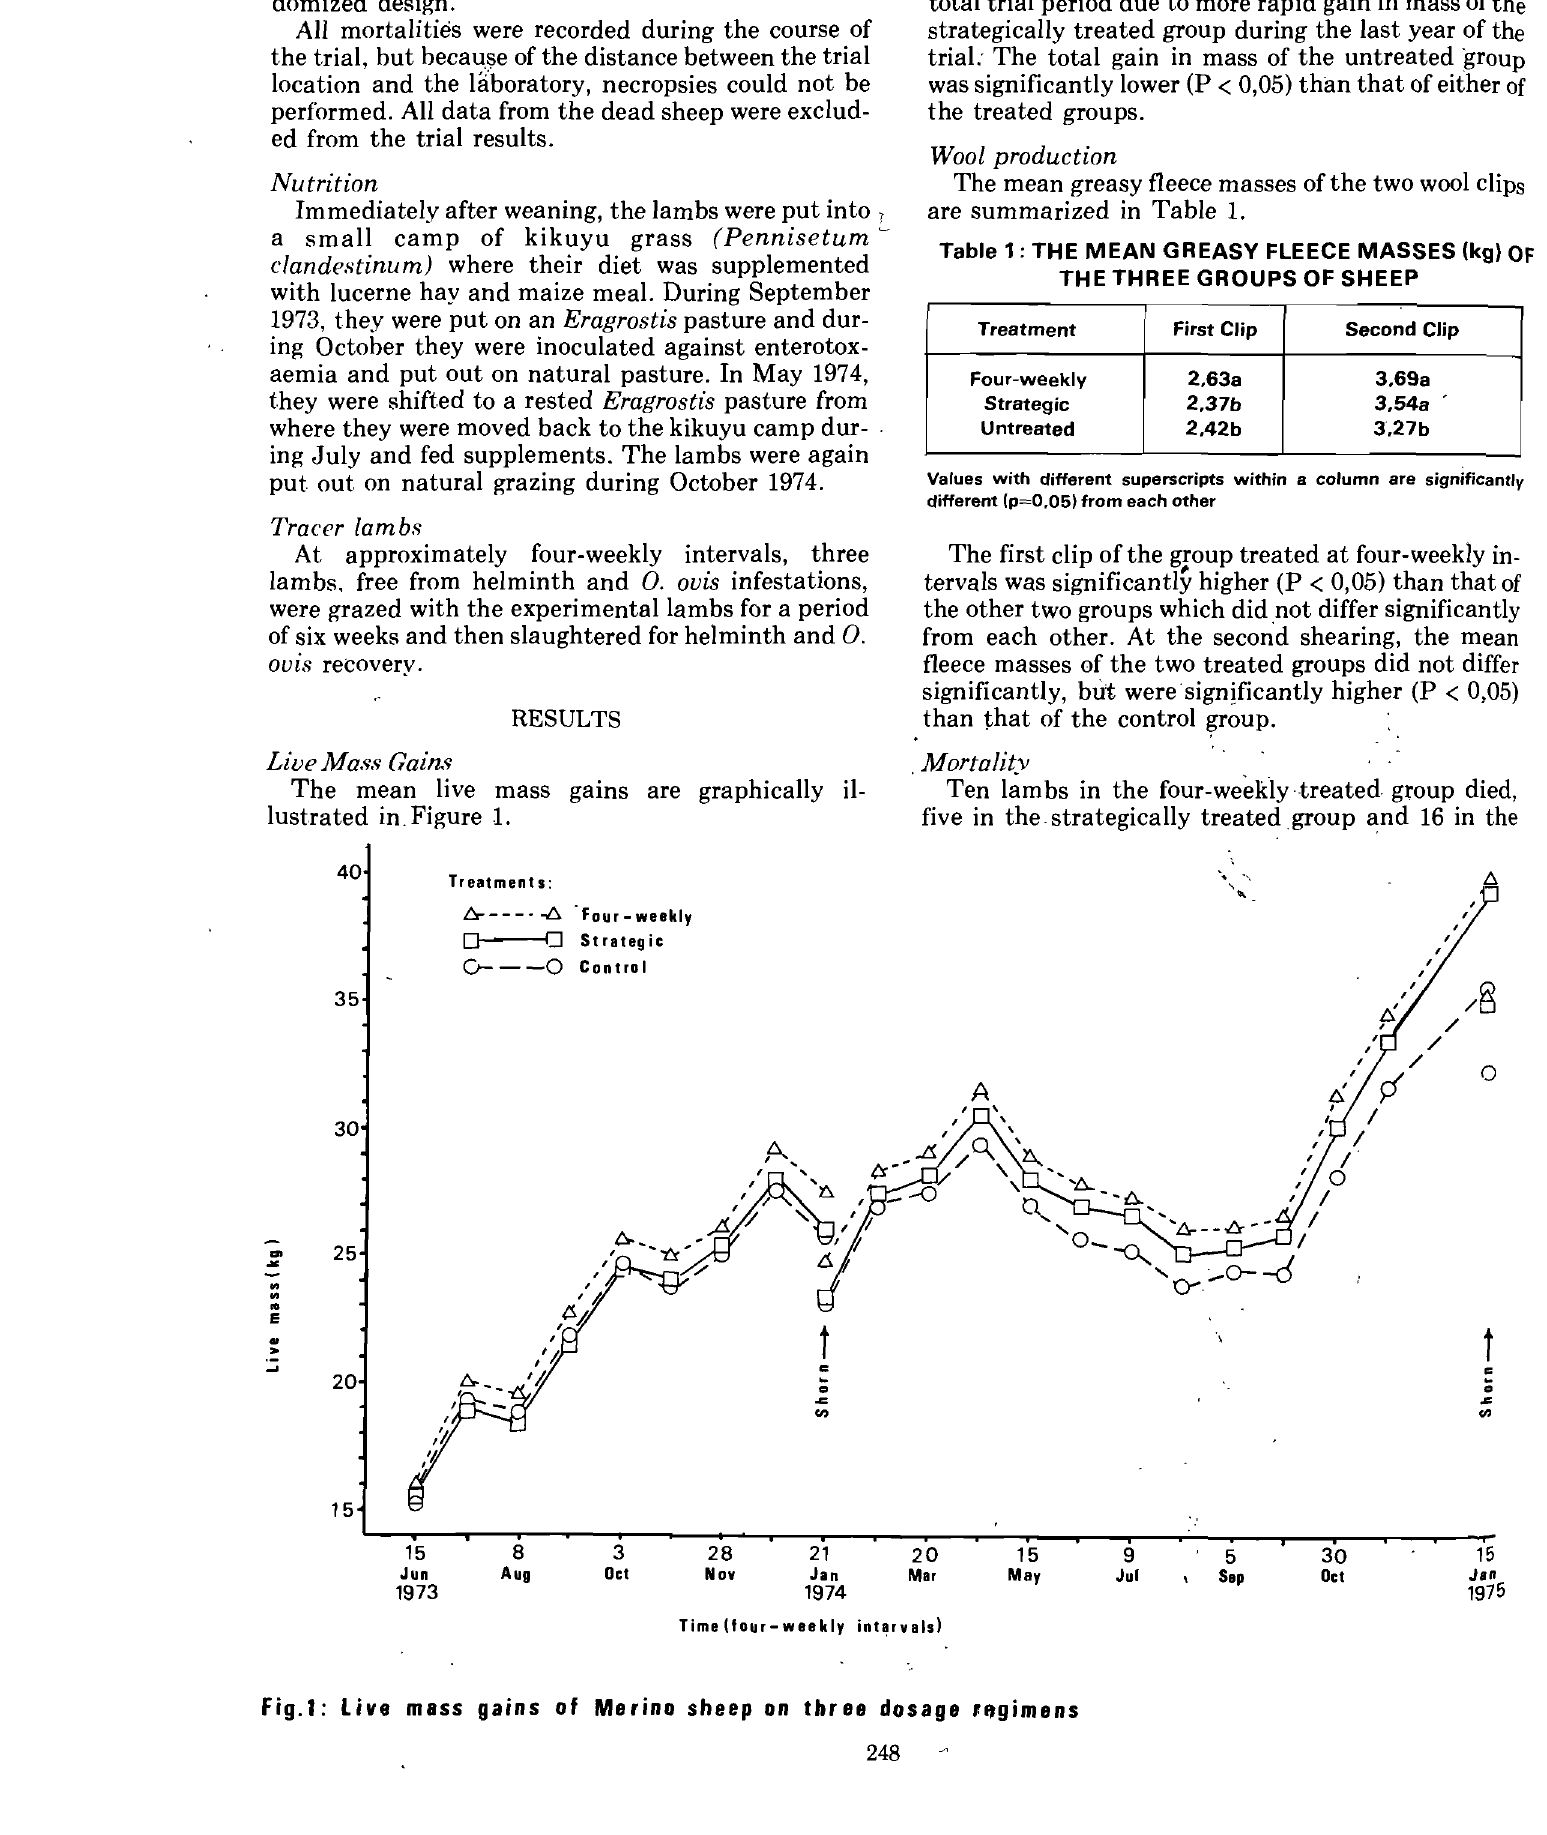
Fig.1 : Live mass gains of Merino sheep on thr ee dosage